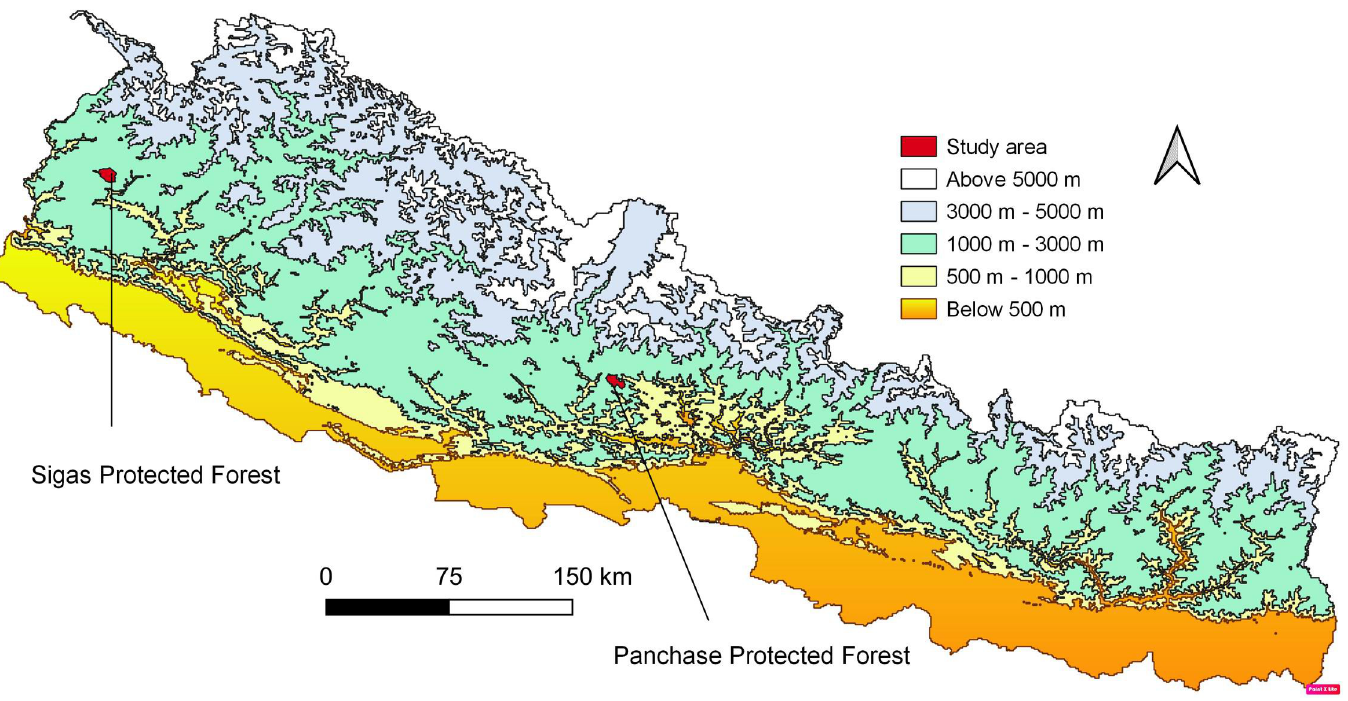
Fig 1. The map shows the intensive study area with elevation and physiographic regions. Data for this map was downloaded from ICIMOD